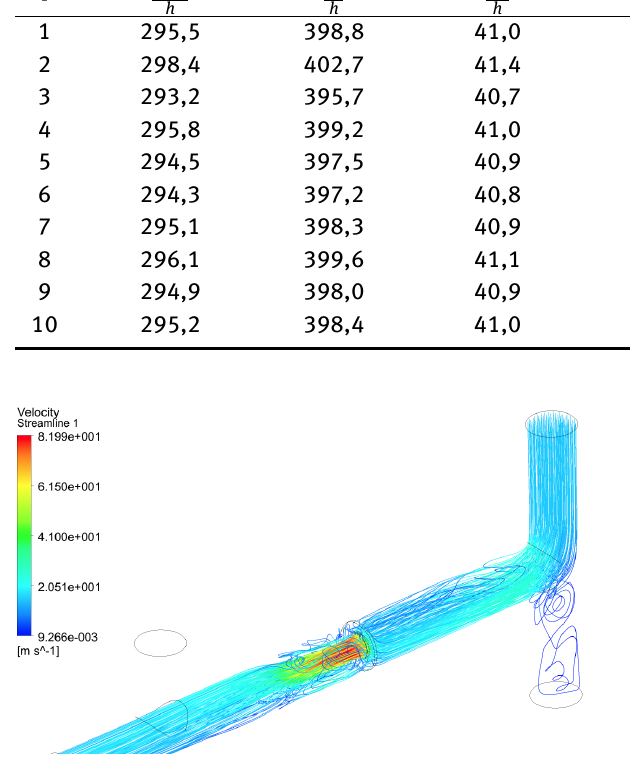
Figure 12: The results of numerical simulation in the form of a veloc- ity